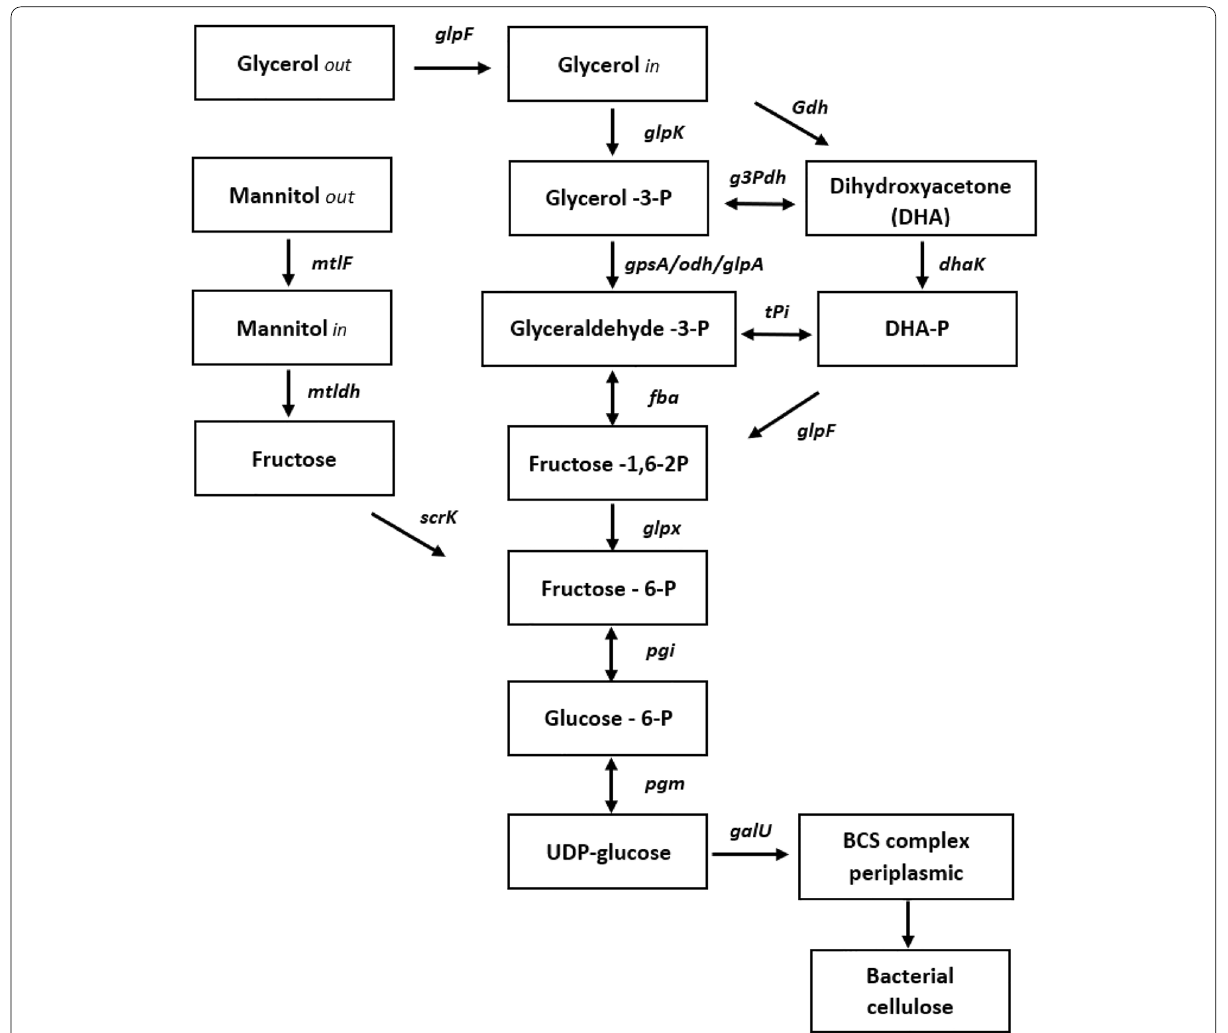
Fig. 1 Metabolic pathways of bacterial cellulose synthesis from glycerol and mannitol by acetic acid bacteria. Gene names and gene products. Adapted from Azuma et al. 2009 and Lu et al. 2020. Gene names and gene products: pgi: glucose-6-phosphate isomerase; glpX: fructose-1,6-bisphosphatase II; fba: fructose-bisphosphate aldolase, class II; pgm: phosphoglucomutase; galU: UTP-glucose-1-phosphate uridylyl transferase; glpK: glycerol kinase; gpsA/odh/glpA: glycerol-3-phosphate dehydrogenase; glpF: glycerol facilitator; dhaK: dihydroacetone kinase; gdh: glycerol dehydrogenase; g3pdh: glyceraldehyde-3-phosphate dehydrogenase; mtlF: mannitol facilitator; mtldh: mannitol